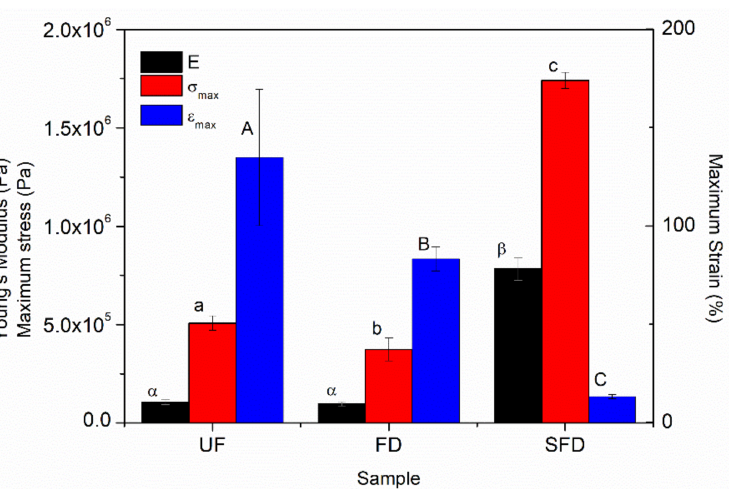
Figure 5. Mechanical parameters of porcine plasma protein-glycerol materials using UF, FD, and SFD protein systems, obtained through uniaxial tensile tests at a deformation rate of 1 mm/s. Average values marked with different lower-case or upper-case Greek letters are statistically different ( p < 0.05).